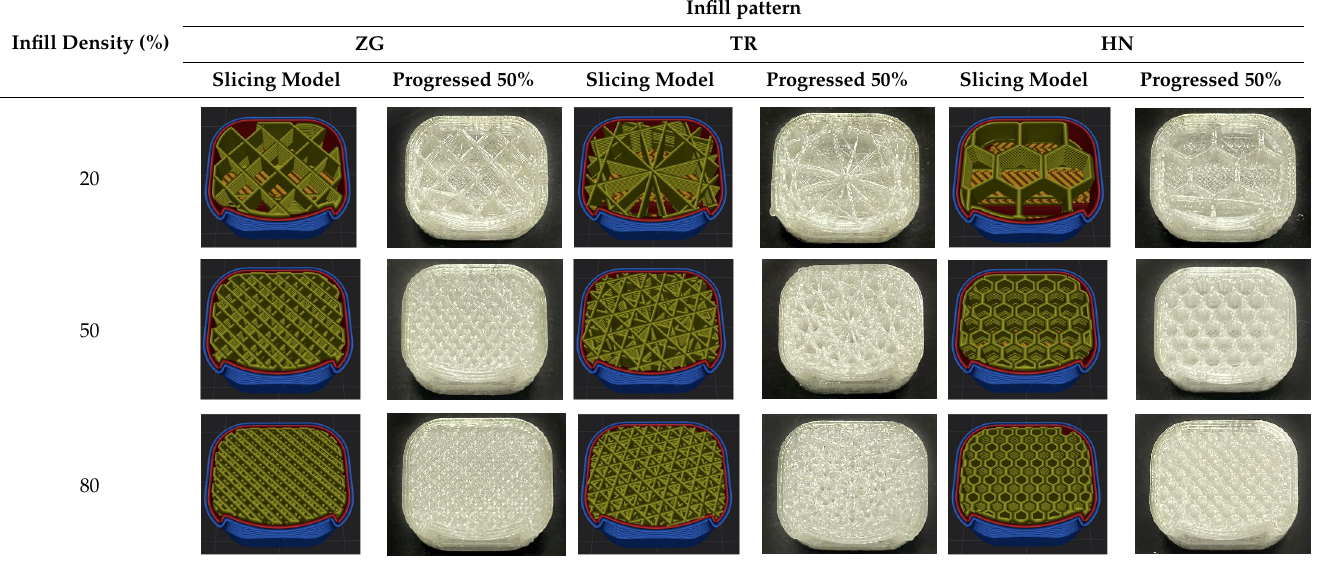
Table 1. Infill image of 3DP fingertips of index under various infill patterns and densities. Table 1. In fi ll image of 3DP fi ngertips of index under various in fi ll pa tt erns and densities. Table 1. In fi ll image of 3DP fi ngertips of index under various in fi ll pa tt erns and densities. Table 1. In fi ll image of 3DP fi ngertips of index under various in fi ll pa tt erns and densities. Table 1. In fi ll image of 3DP fi ngertips of index under various in fi ll pa tt erns and densities. Table 1. In fi ll image of 3DP fi ngertips of index under various in fi ll pa tt erns and densities. Table 1. In fi ll image of 3DP fi ngertips of index under various in fi ll pa tt erns and densities. Table 1. In fi ll image of 3DP fi ngertips of index under various in fi ll pa tt erns and densities. Table 1. In fi ll image of 3DP fi ngertips of index under various in fi ll pa tt erns and densities. Table 1. In fi ll image of 3DP fi ngertips of index under various in fi ll pa tt erns and densities. Table 1. In fi ll image of 3DP fi ngertips of index under various in fi ll pa tt erns and densities. Table 1. In fi ll image of 3DP fi ngertips of index under various in fi ll pa tt erns and densities. Table 1. In fi ll image of 3DP fi ngertips of index under various in fi ll pa tt erns and densities. Table 1. In fi ll image of 3DP fi ngertips of index under various in fi ll pa tt erns and densities. Table 1. In fi ll image of 3DP fi ngertips of index under various in fi ll pa tt erns and densities. Table 1. In fi ll image of 3DP fi ngertips of index under various in fi ll pa tt erns and densities. Table 1. In fi ll image of 3DP fi ngertips of index under various in fi ll pa tt erns and densities. Table 1. In fi ll image of 3DP fi ngertips of index under various in fi ll pa tt erns and densities. Table 1. In fi ll image of 3DP fi ngertips of index under various in fi ll pa tt erns and densities. Table 1. In fi ll image of 3DP fi ngertips of index under various in fi ll pa tt erns and densities. Table 1. In fi ll image of 3DP fi ngertips of index under various in fi ll pa tt erns and densities. Table 1. In fi ll image of 3DP fi ngertips of index under various in fi ll pa tt erns and densities. Table 1. In fi ll image of 3DP fi ngertips of index under various in fi ll pa tt erns and densities. Table 1. In fi ll image of 3DP fi ngertips of index under various in fi ll pa tt erns and densities. Table 1. In fi ll image of 3DP fi ngertips of index under various in fi ll pa tt erns and densities. Table 1. In fi ll image of 3DP fi ngertips of index under various in fi ll pa tt erns and densities. Table 1. In fi ll image of 3DP fi ngertips of index under various in fi ll pa tt erns and densities. Table 1. In fi ll image of 3DP fi ngertips of index under various in fi ll pa tt erns and densities. Table 1. In fi ll image of 3DP fi ngertips of index under various in fi ll pa tt erns and densities. Table 1. In fi ll image of 3DP fi ngertips of index under various in fi ll pa tt erns and densities. Table 1. In fi ll image of 3DP fi ngertips of index under various in fi ll pa tt erns and densities. Table 1. In fi ll image of 3DP fi ngertips of index under various in fi ll pa tt erns and densities. Table 1. In fi ll image of 3DP fi ngertips of index under various in fi ll pa tt erns and densities. Table 1. In fi ll image of 3DP fi ngertips of index under various in fi ll pa tt erns and densities. Table 1. In fi ll image of 3DP fi ngertips of index under various in fi ll pa tt erns and densities. Table 1. In fi ll image of 3DP fi ngertips of index under various in fi ll pa tt erns and densities. Table 1. In fi ll image of 3DP fi ngertips of index under various in fi ll pa tt erns and densities. Infill Density (%)